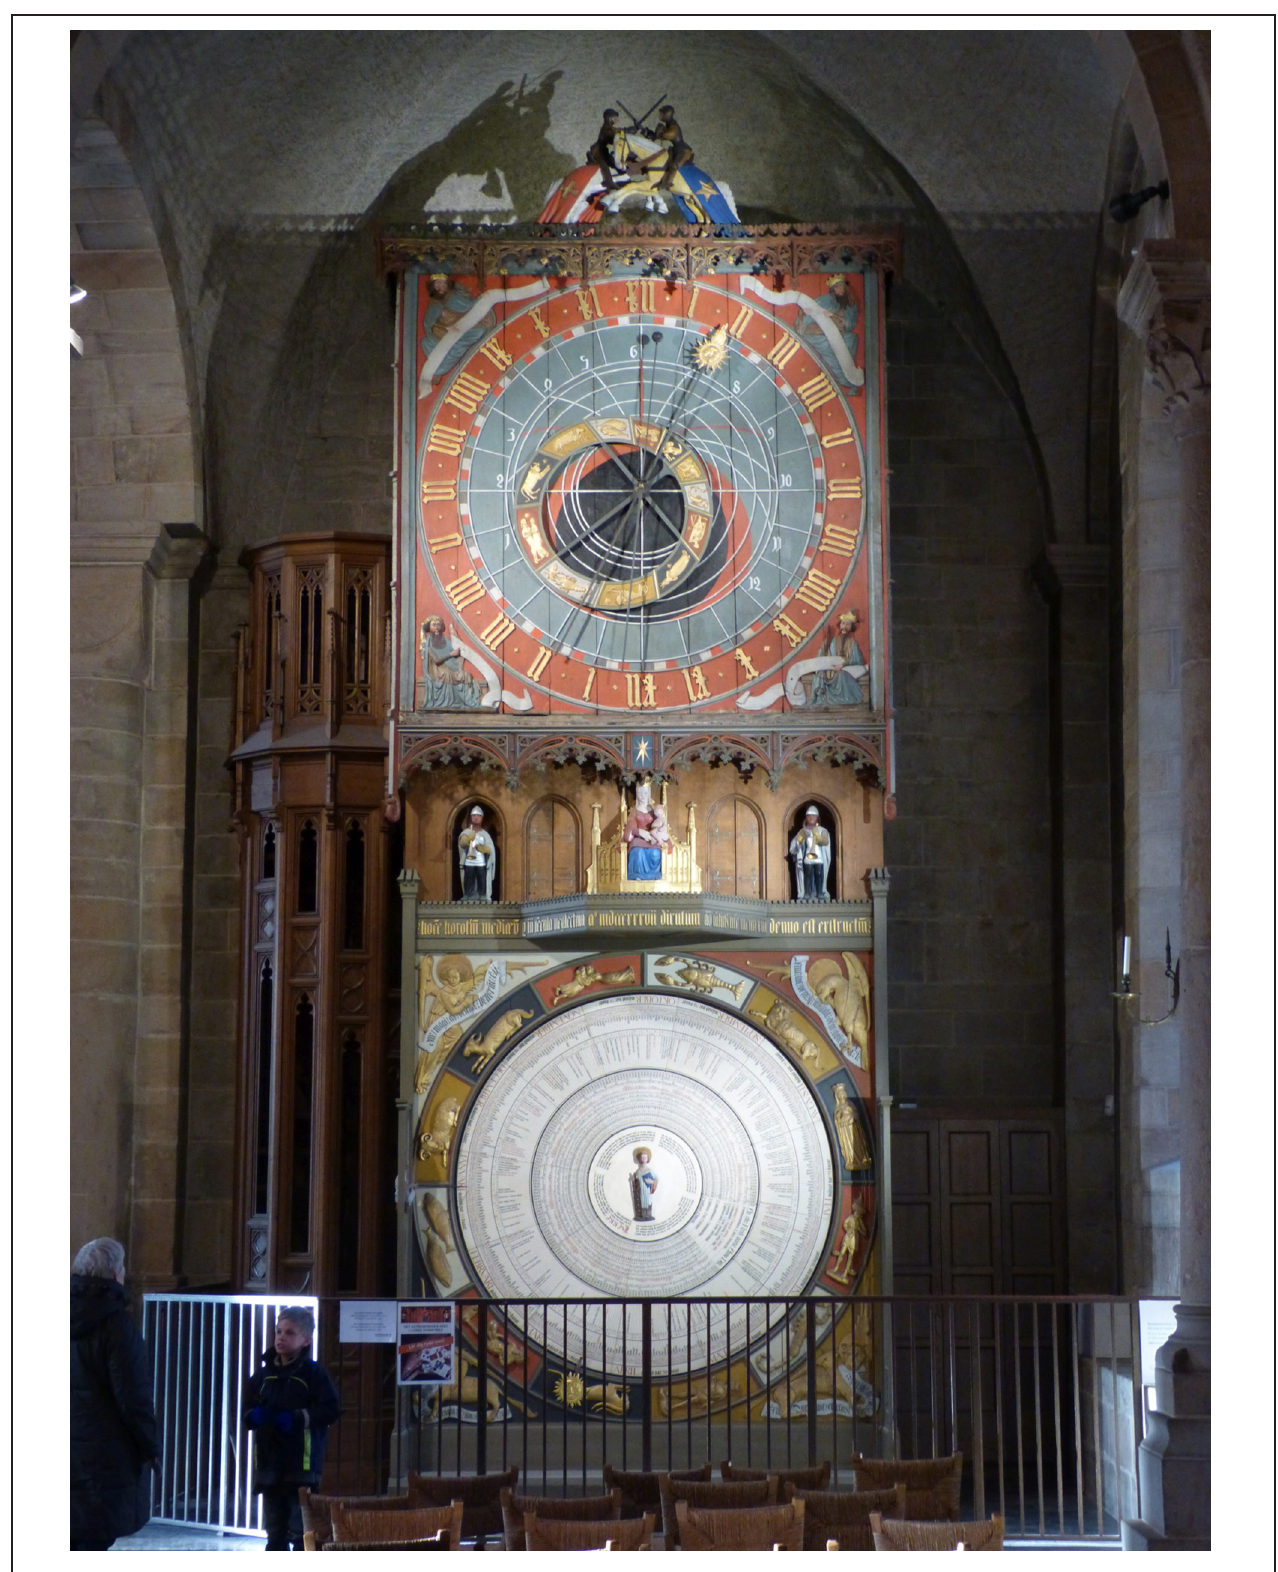
FIGURE 4 | A restored medieval clock in Lund Cathedral, Sweden. Image © Chris Sinha.